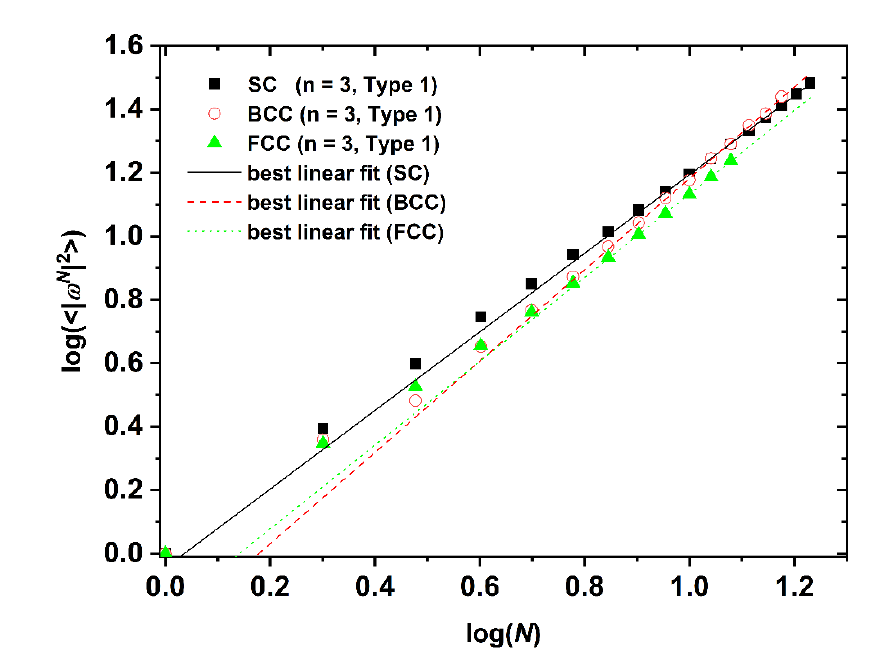
(cid:12) (cid:12) 2 (cid:105) (cid:12) (cid:12) , as a function of logarithm (cid:12) ω N (cid:12)